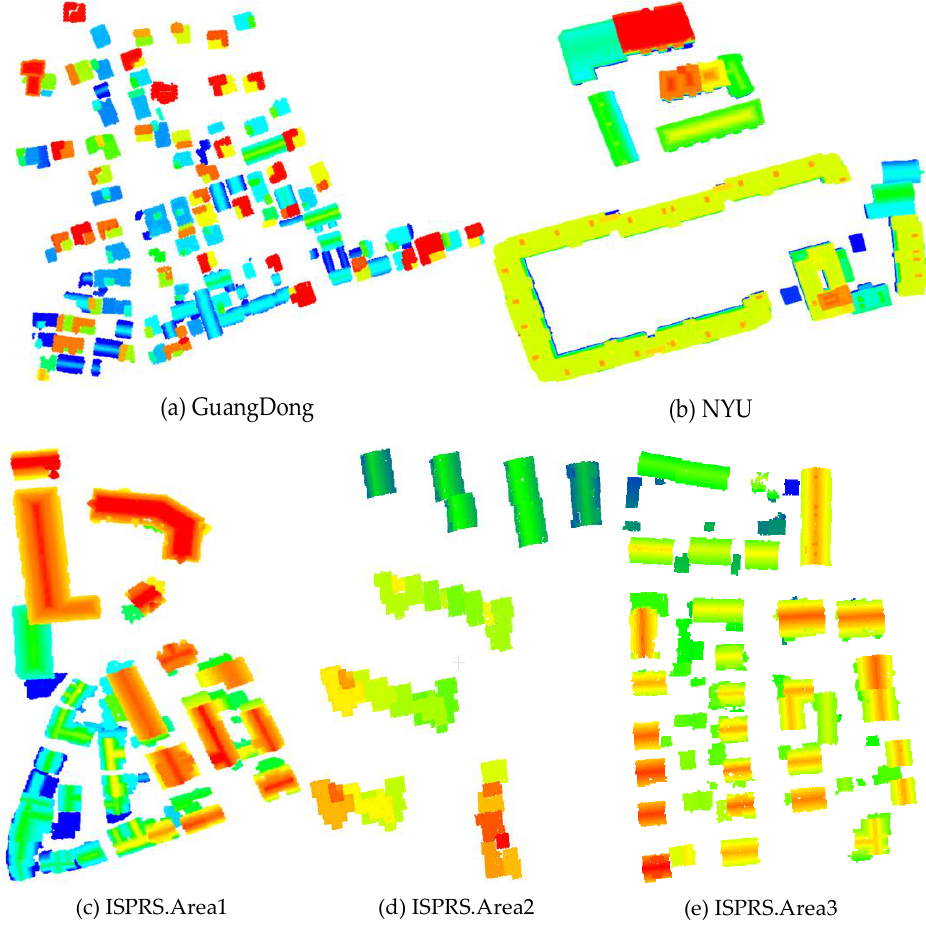
Figure 7. An overview of the tested datasets.